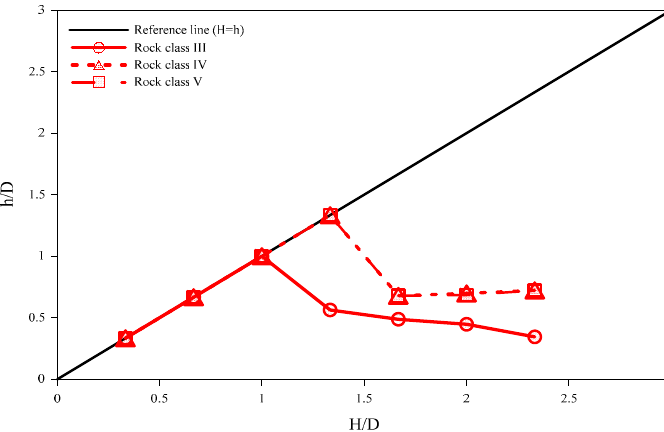
Figure 11. Relation between H / D and h / D from the stress variable method.